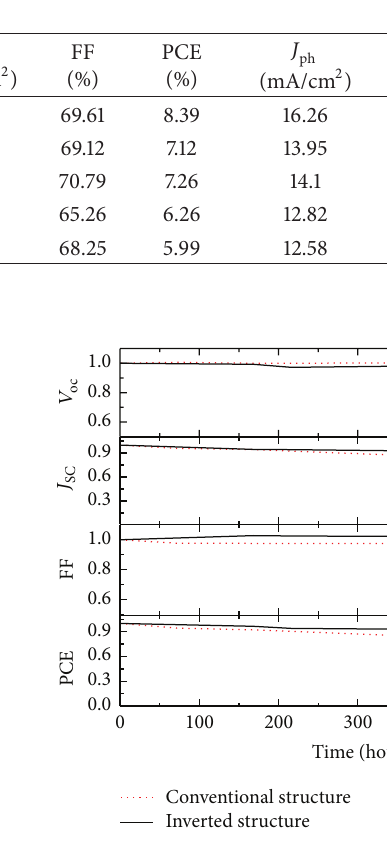
Figure 3: Normalized photovoltaic parameters of conventional and inverted PSCs as a function of storage time. The values are averages of five devices.